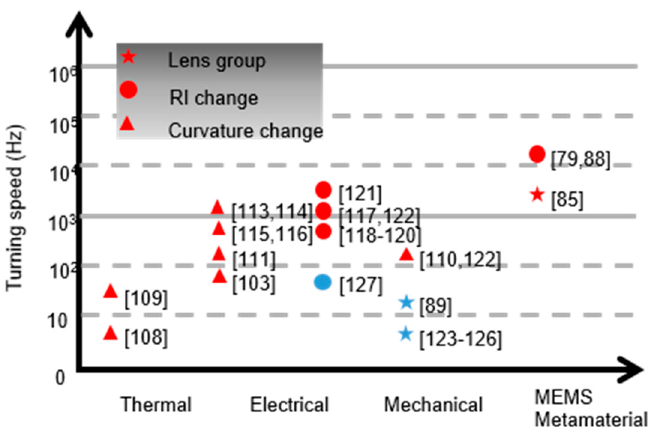
Figure 8. Tunable lenses realized by various approaches. ( a ) Curvature change of lens with soft materials; ( b ) tunable lens realized by changing the refractive index of materials; ( c ) adjustable-focus endoscope realized by lens group based on Alvarez principle. Figure 8a–c are reprinted with permission from [106] copyright by OSA Publishing, 2017, [107] copyright by OSA Publishing, 2018, and [89] copyright by OSA Publishing, 2015, respectively.